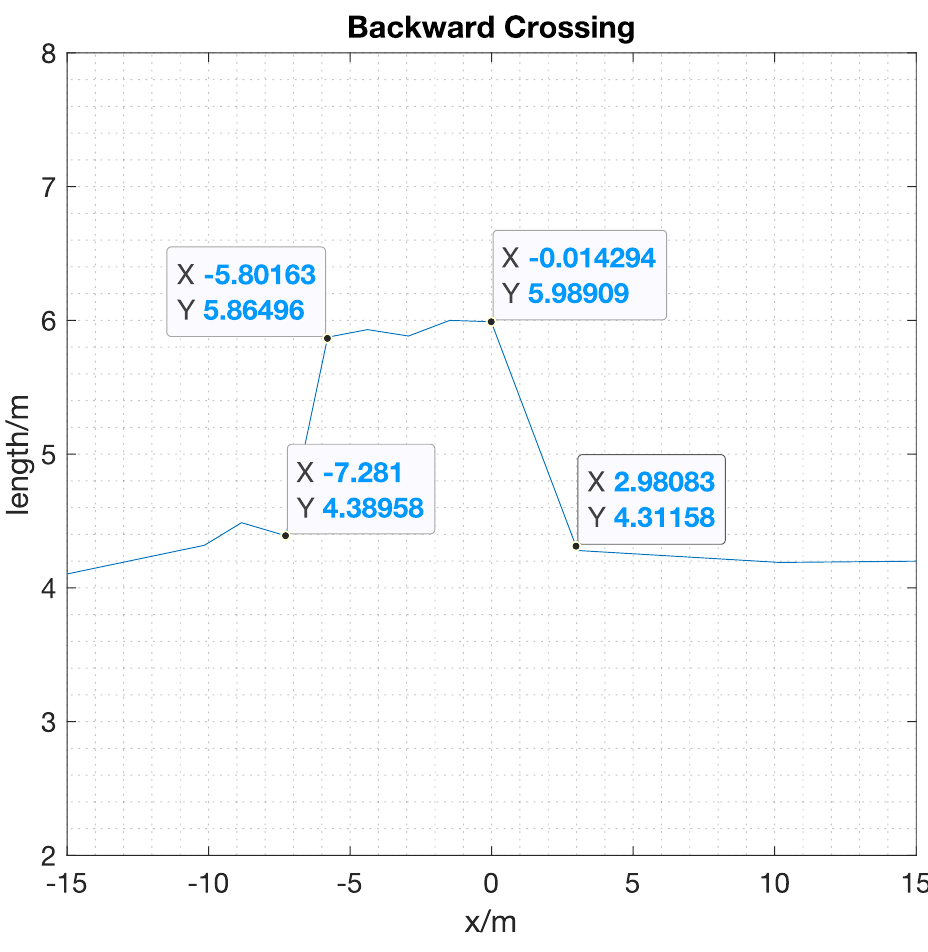
Figure 9. Change of vehicle length in a backward